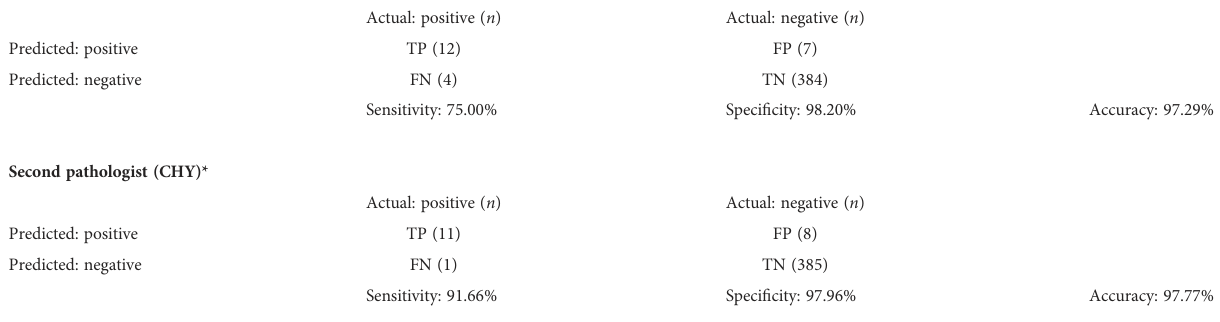
TABLE 5 Confusion matrix and performance of the model used for pathological validation of perineural invasion (whole slide images). First pathologist